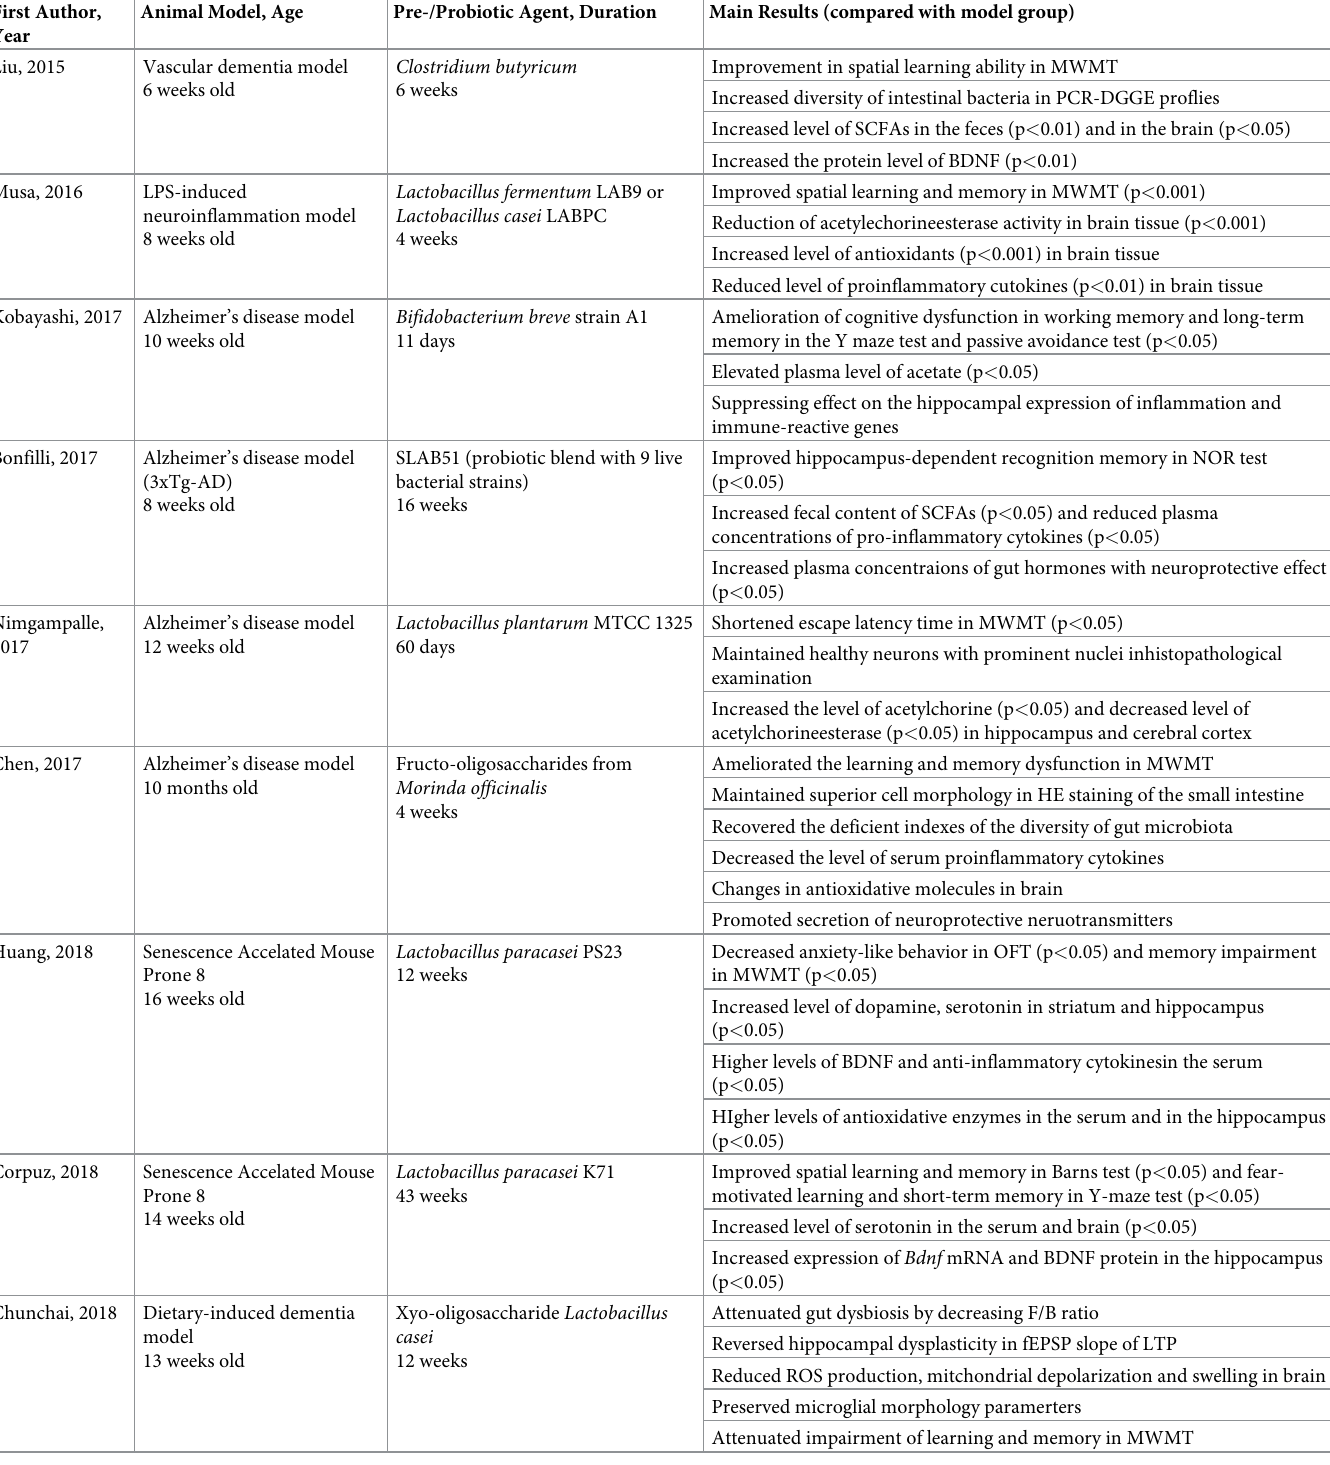
Table 2. Summary of interventional studies with pre- or probiotics in rodents with cognitive